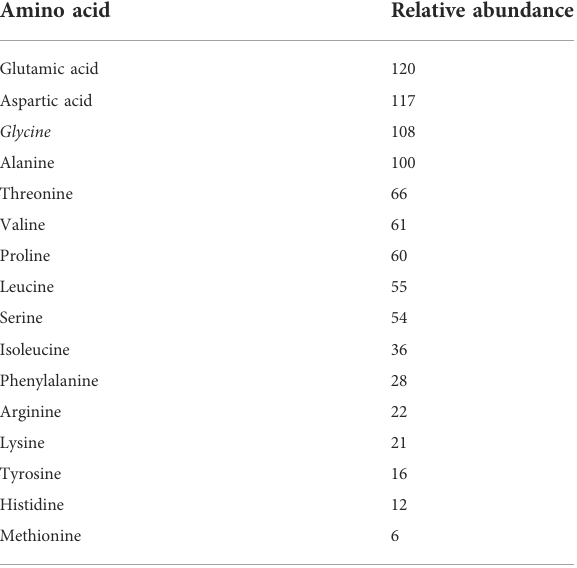
TABLE 3 Amino acid composition in G. lucidum (Sudheer et al.,